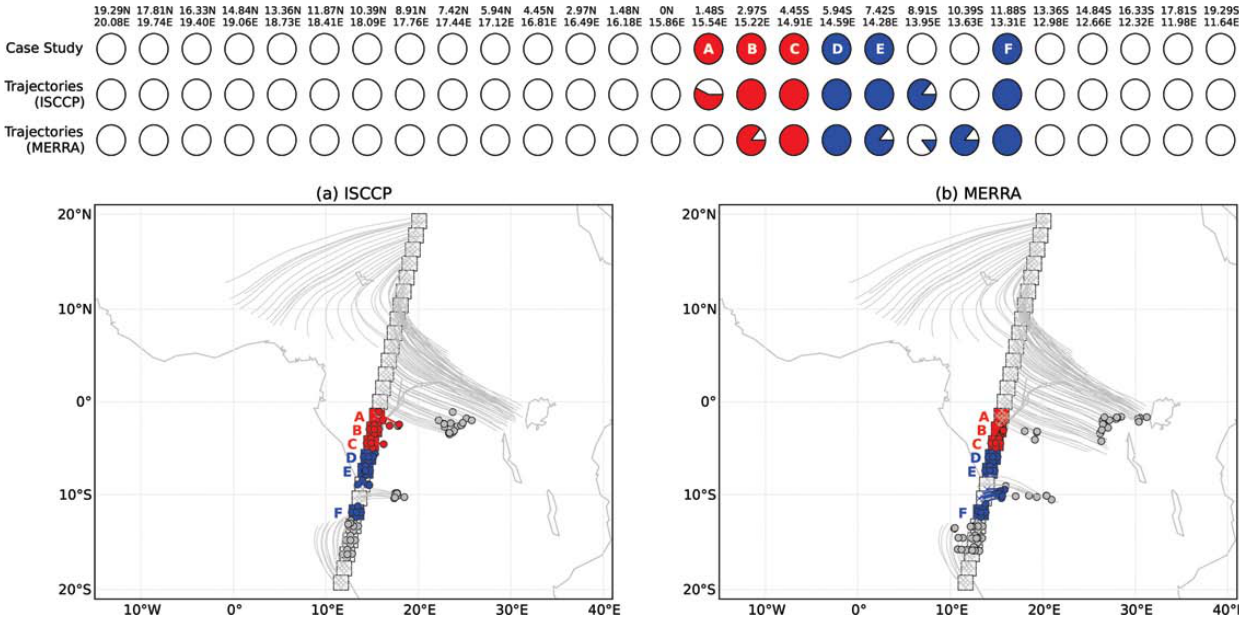
Fig. 3. Results of the trajectory analysis of CO transport for the case study shown in Fig. 2. (a) The evolution of trajectories (lines) and locations of convective sources (circles) according to ISCCP DX cloud tops. The pathway identified by the automated method is indicated by the color of the underlying square (red for “local convection”; blue for “LT advection → convection”), and the pathway identified by each trajectory is indicated by the color of the line and terminating circle (if any). (b) As in (a) , but according to MERRA cloud tops. The rows of circles along the top indicate the pathways identified by the automated method (first row), trajectories with ISCCP DX cloud tops (second row), and trajectories with MERRA cloud tops (third row) for individual MLS observations. Partially filled circles indicate fractions of trajectory ensembles. The labeled circles in the first row correspond to the similarly annotated locations in (a) and (b) .